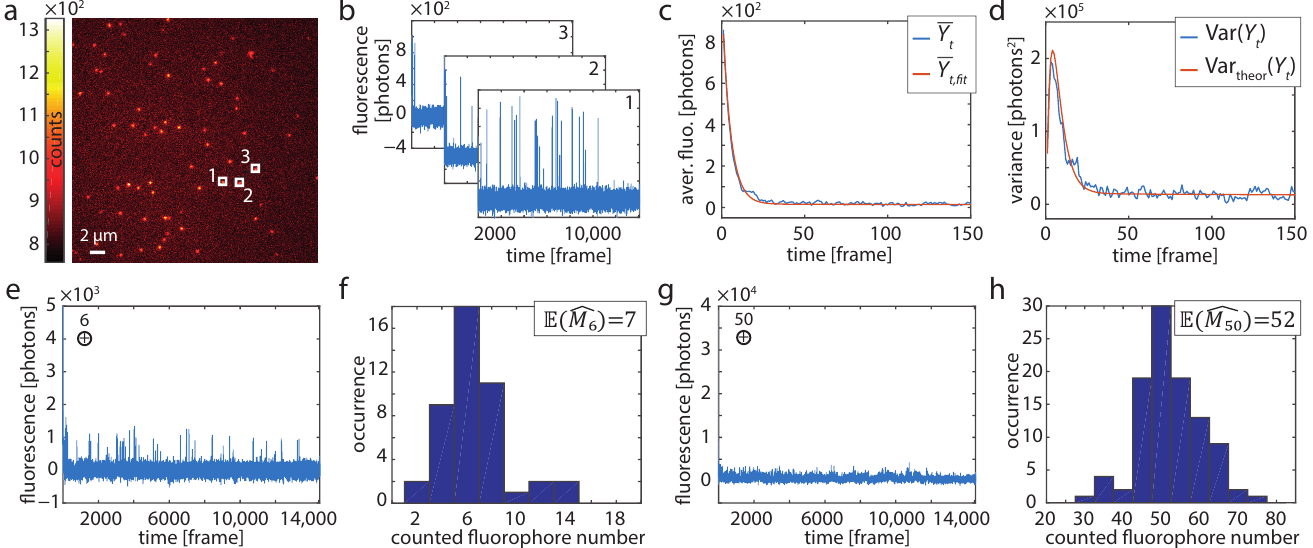
Figure 1. Single-molecule experiments. ( a ) First frame ( t = 1) of a recording of DNA origami struc- tures exhibiting one labeling position. ( b ) Background-corrected time traces of the three 7 × 7 pixel sized evaluation regions indicated in A (white boxes). ( c ) Averaged trace and ( d ) corresponding variance from 255 origami structures (blue). The red lines in ( c , d ) show the fit of the HTMM and the theoretical variance, respectively. ( e ) Six traces (such as shown in b) were added at a time to generate traces of known fluorophore number m . ( f ) Histogram of the estimated number of dye molecules from 45 added traces modeling m = 6. ( g ) Same as ( e ) for m = 50. ( h ) Histogram of the estimated number of dye molecules from 100 added traces modeling m =